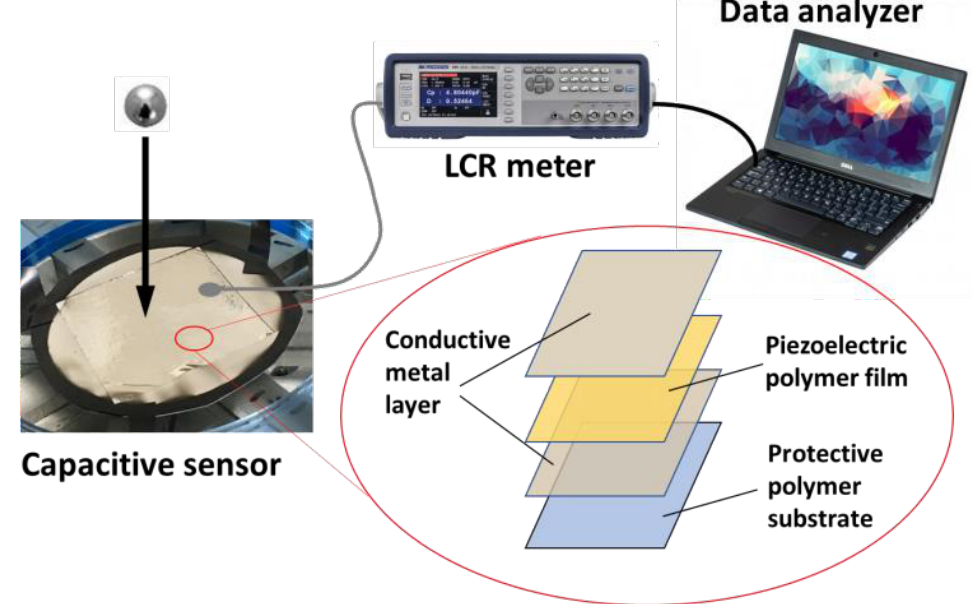
Figure 8. Setup for capacitive pressure sensors based on piezoelectric stretchable polymer films.